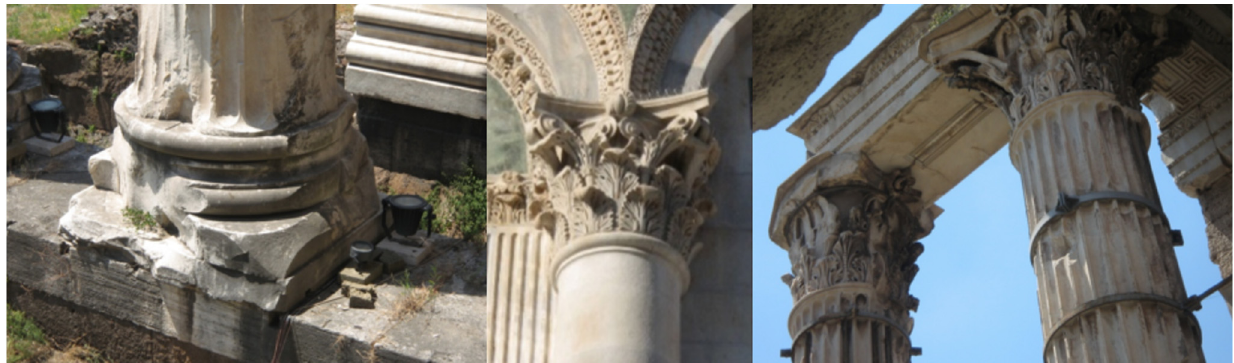
Figure 3. Repetitive shapes detected in historical